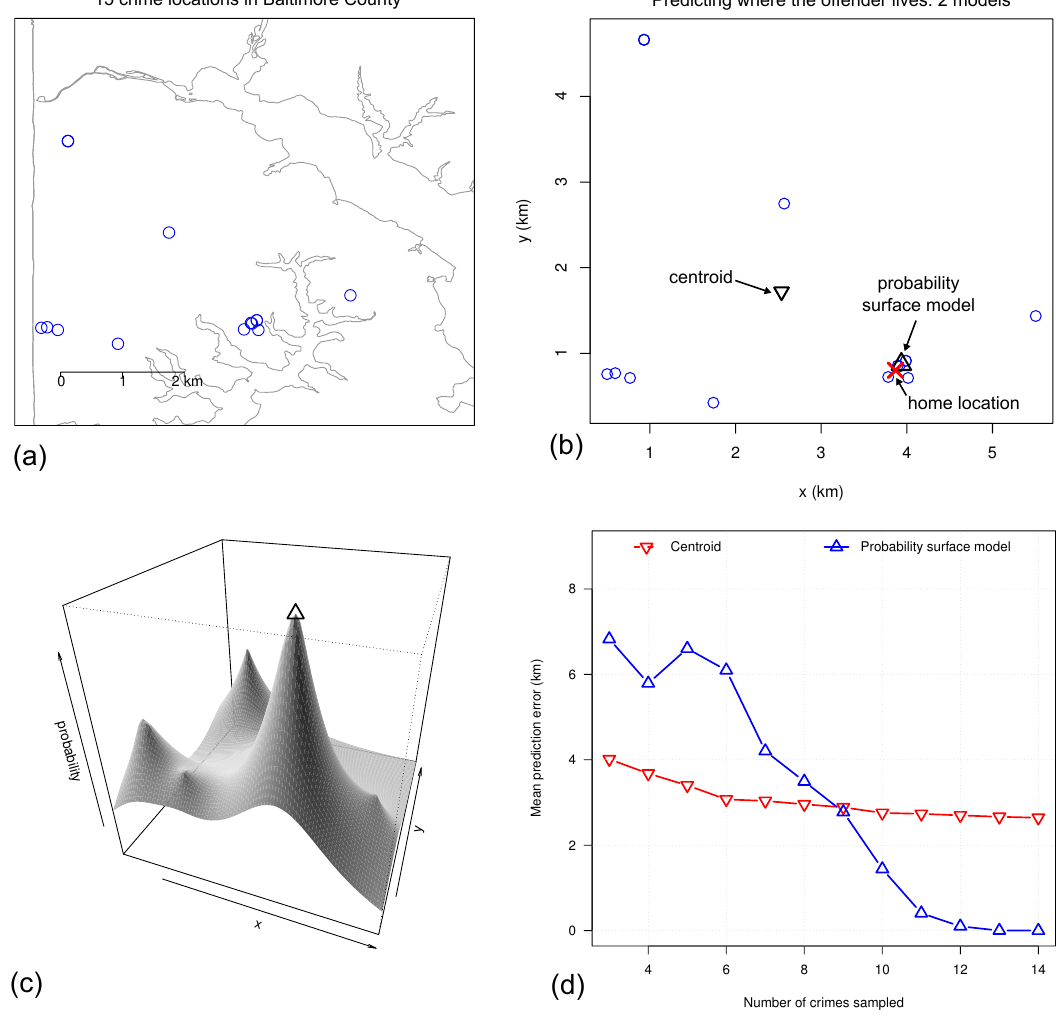
Figure 1 Panel (a) plots the locations of 15 burglaries committed by a single offender in Baltimore County. Panel (b) plots the true home location of the offender and the home locations predicted by the centroid method and a probability surface model with an exponential decay function depicted in (c). Panel (d) plots the prediction error of the two models as a function of the number of crimes sampled. The relative superiority of the two models inverts after 9 crimes have been observed. Note: Crime locations visually overlap in 5